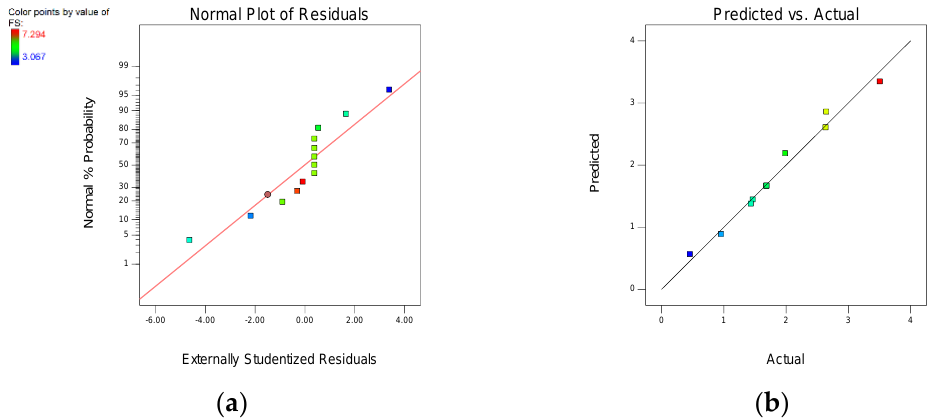
Figure 17. ( a ) Normal Plot for the Residual and ( b ) Predicted Versus Actual Plot for the TS model.